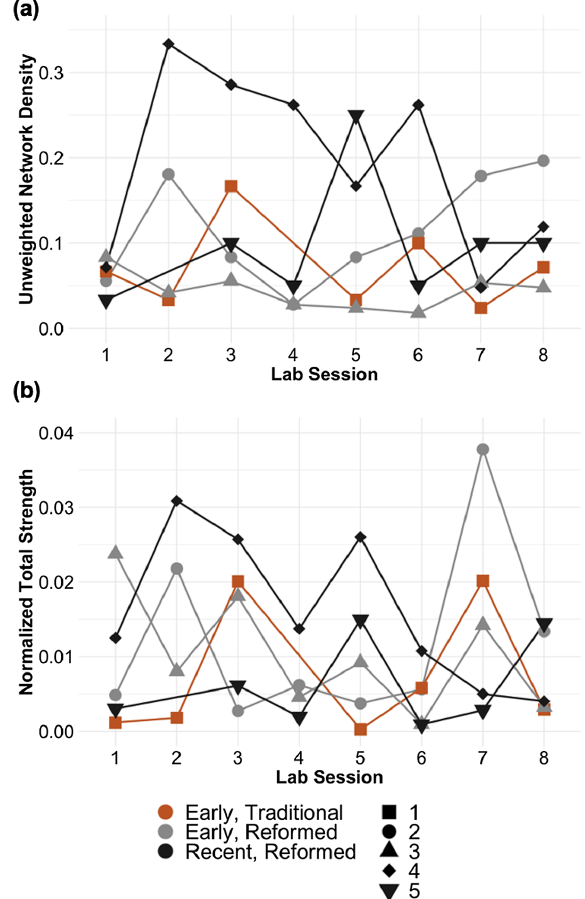
FIG. 3. (a) Unweighted network density, the proportion of observed edges to possible edges between groups, plotted over time for all coded lab sessions. (b) Normalized total strength, the sum of durations of all observed intergroup interactions scaled by the length of the lab session and number of groups present, over time for all coded lab sessions. Colors indicate the lab curriculum and shapes indicate the lab